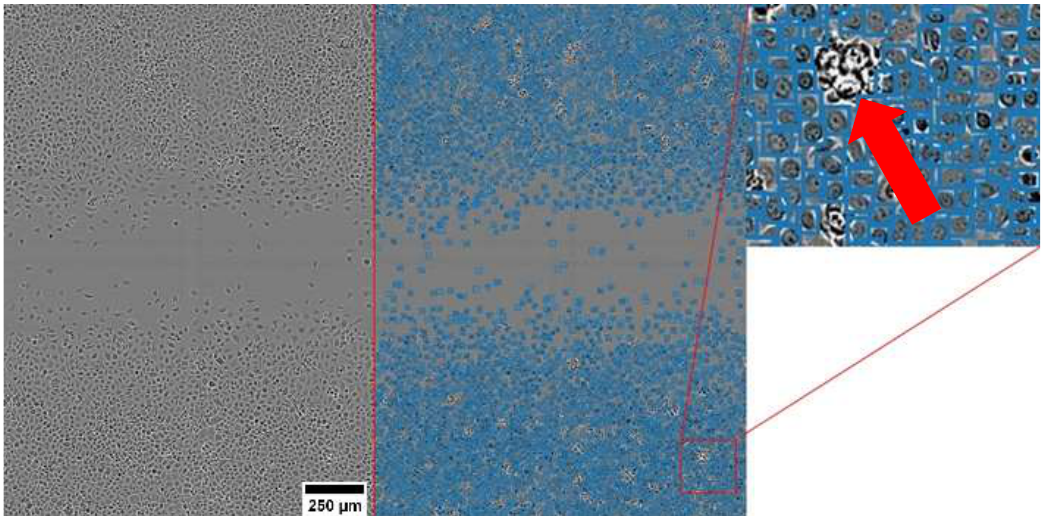
Figure 2. EPIC cell detection in a low-resolution and high-density wound repair image of the control experiment type. Left panel: unlabeled raw image, middle panel: same image with cell detections marked with blue bounding boxes, and right panel: enlarged region of middle panel showing accurate cell detections (blue boxes) and a large unlabeled region of cell debris (indicated by red arrow).